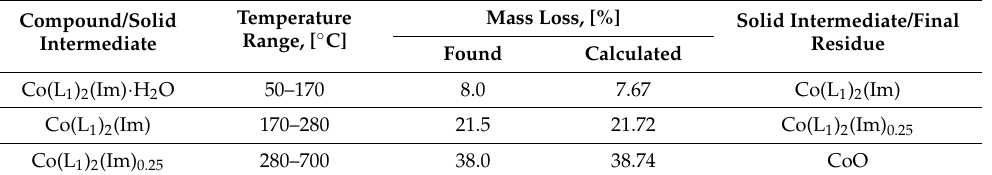
Table 4. TG-DTG analysis data of decomposition of Co(L 1 ) 2 (Im) · H 2 O.